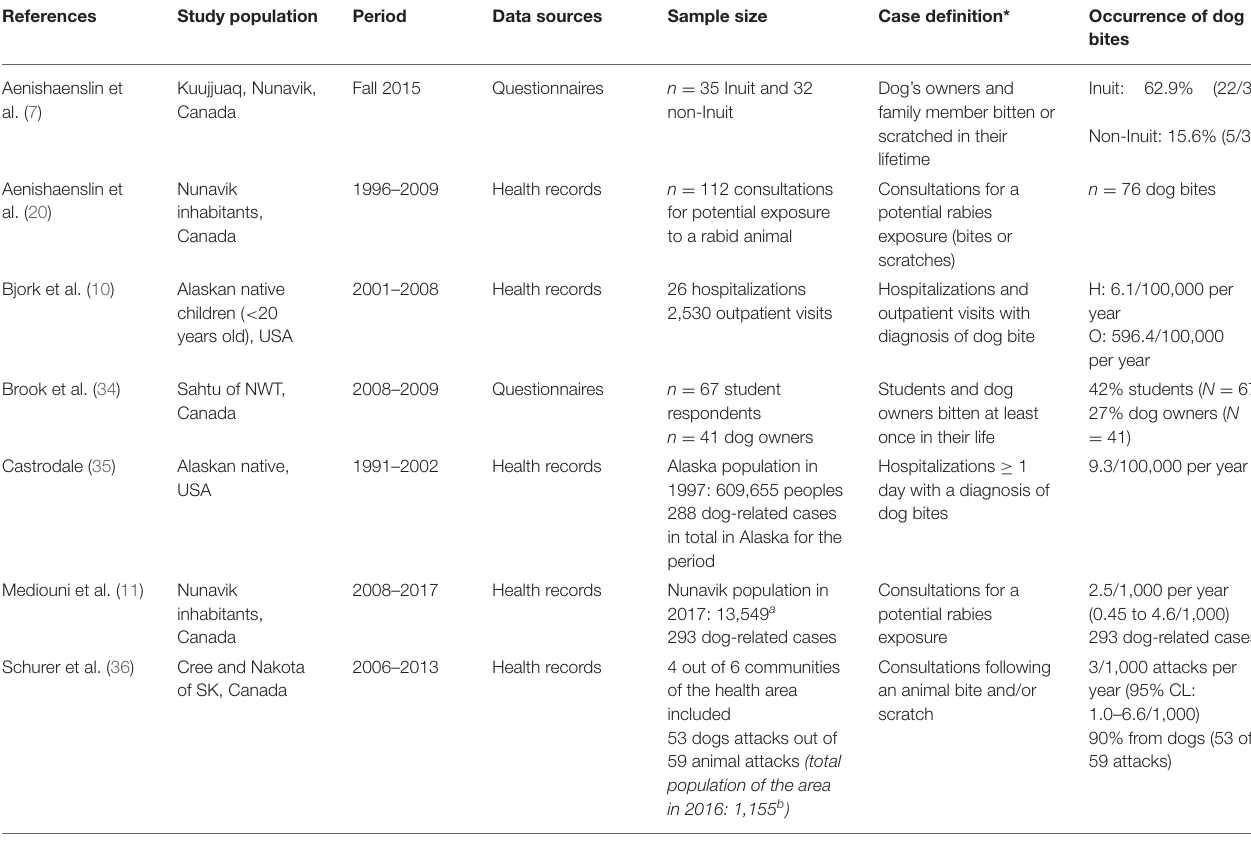
TABLE 2 | Dog bite occurrence in northern Indigenous communities.